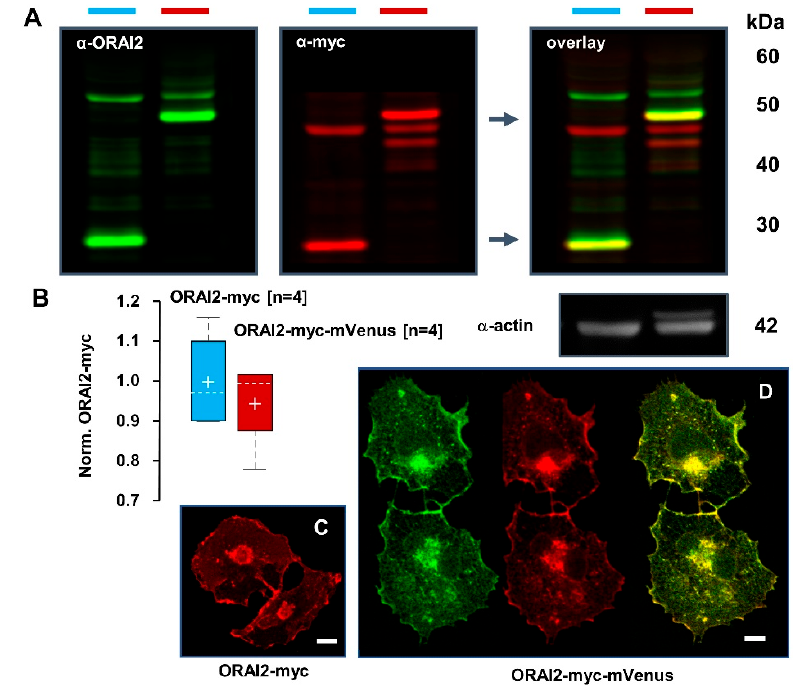
Figure 2. ORAI2-myc and ORAI2-myc-mVenus were similarly expressed in H4 cells. ( A ) Western blots from H4 cells expressing ORAI2-myc or ORAI2-myc-mVenus at 24 h, showing α -ORAI2 (left), α -myc (middle) and their overlay (right). Yellow color indicates the specific Orai2-myc and Orai2-myc-mVenus bands. ( B ) Densitometric analysis of ORAI2-myc and ORAI2-myc-mVenus bands at 25 and 50 kDa upon normalization to α -actin (Norm. ORAI2-myc). ( C , D ) Confocal images of ORAI2 localization in H4 cells upon overexpression of ORAI2-myc ( C ) or ORAI2-myc-mVenus ( D ). mVenus fluorescence is shown in green (left), myc-staining in red (middle) and the overlay in yellow (right); scale bars 10 μ m.